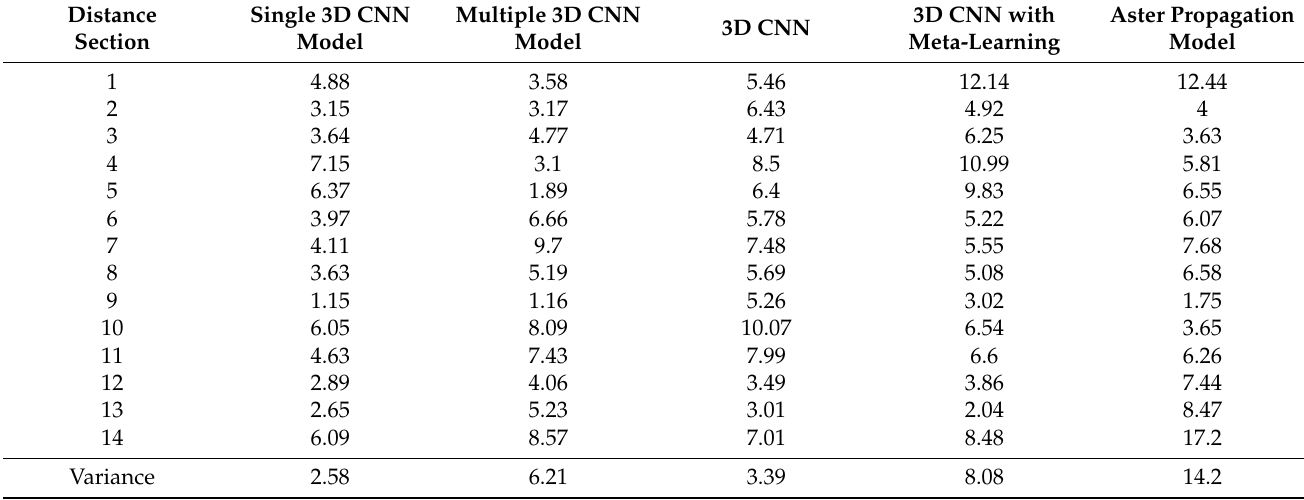
Table 9. Comparison of mean absolute error and error variance according to the distance